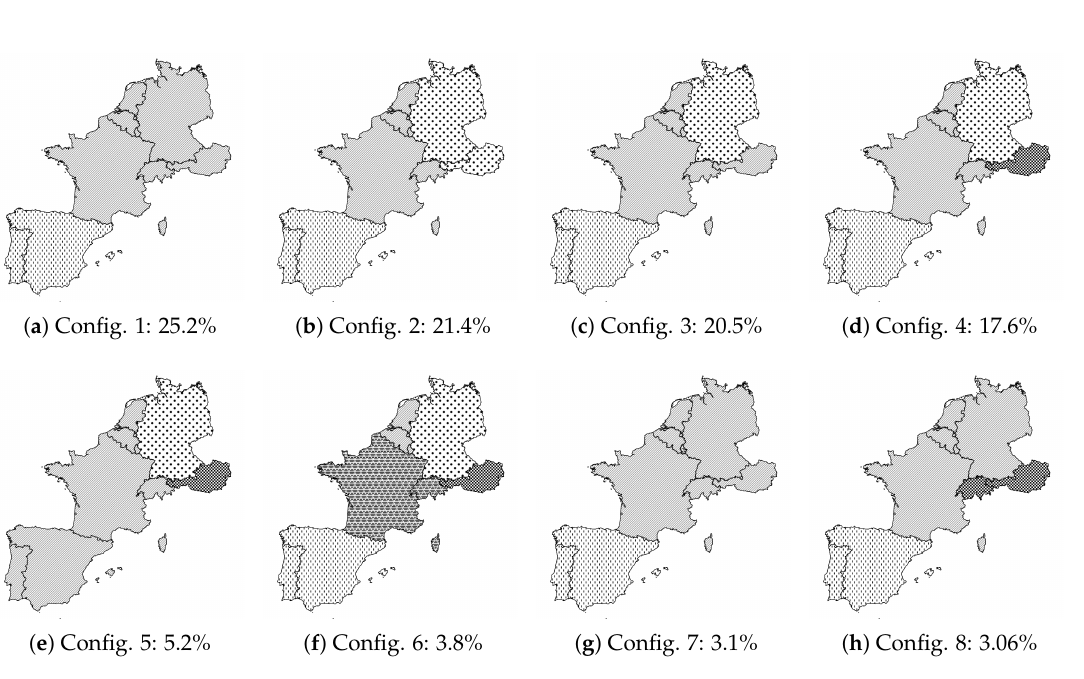
Figure 6. Eight representative network configurations (The different patterns show different prices in the corresponding